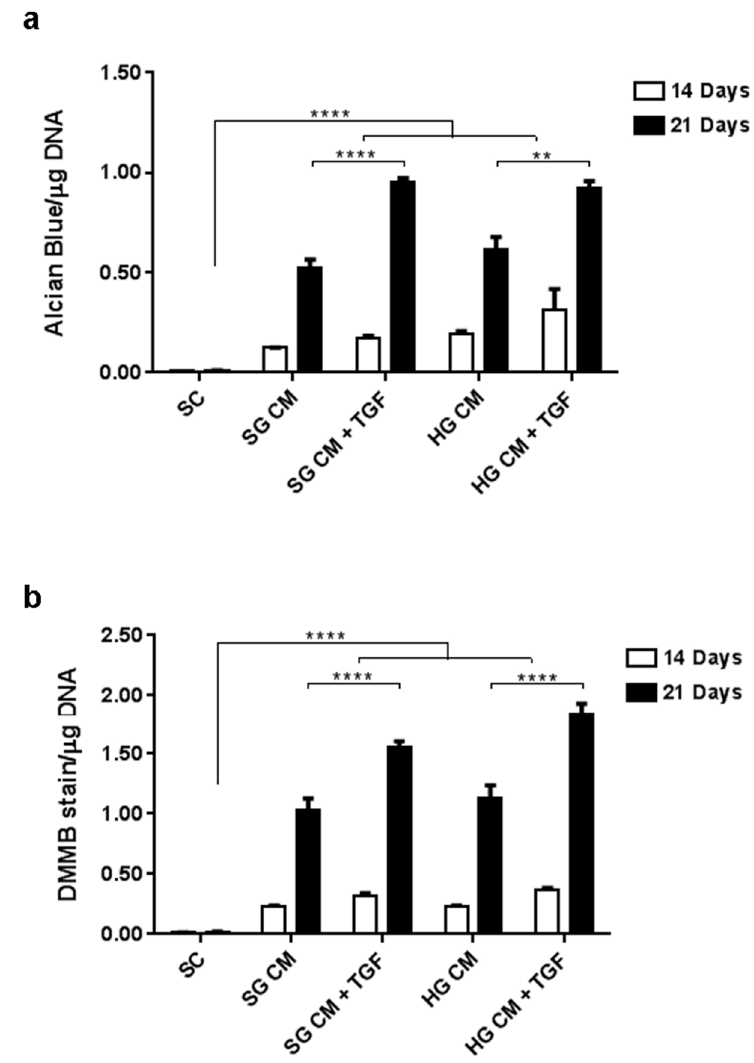
Figure 1. Comparison of standard glucose (SG) and high glucose (HG) media formulations on MSC chondrogenic differentiation assessed in 3D culture at day 14 and 21. ( a ) Alcian blue assay. ( b ) DMMB assay ( n = 6). CM: chondrogenic medium, CM + TGF: chondrogenic medium supplemented with TGF- β 1. ** p < 0.01, **** p < 0.0001. SC: Standard Culture medium, CM: chondrogenic differentiation medium, SG: standard glucose, HG: high